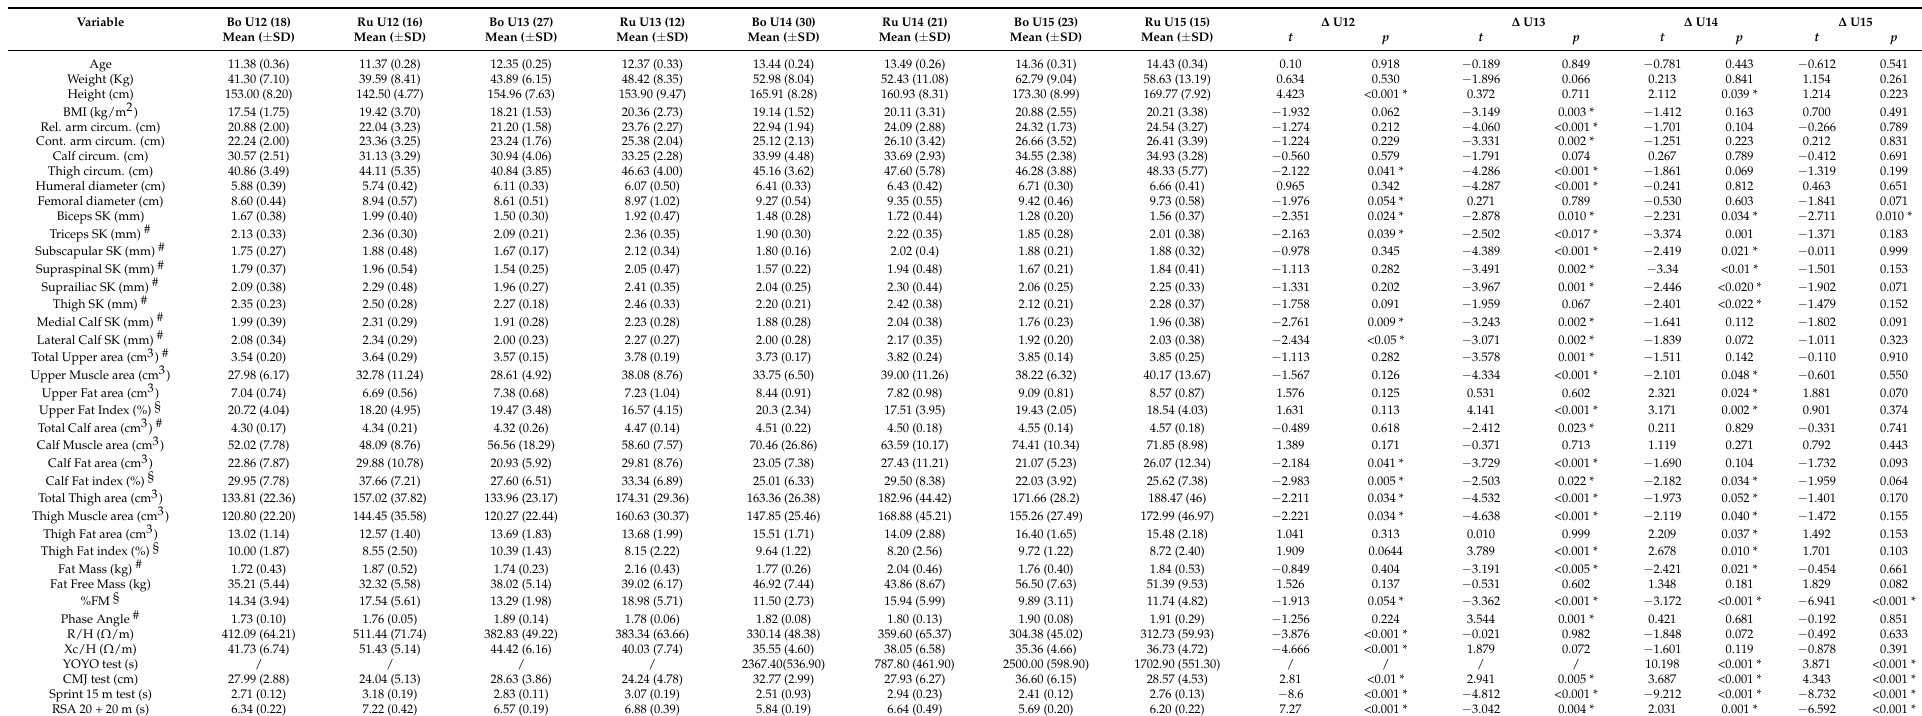
Table 1. Variable statistics of Bologna and Russi Calcio for each